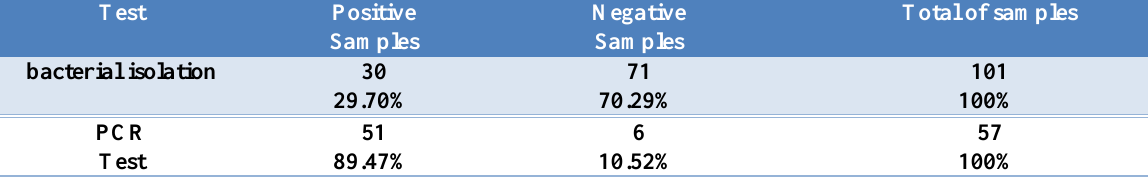
Table , 5: The percentage of PCR reaction. Tests Total of samples Positive samples DNA extraction